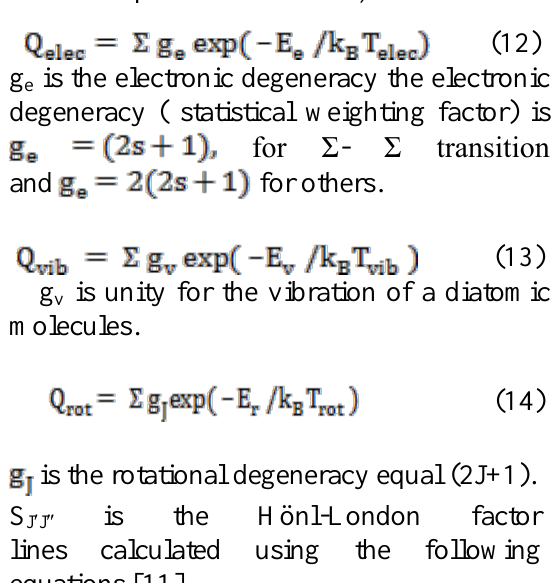
Table 1: The diatomic constants for the ground states and the excited state of BeO used in calculation